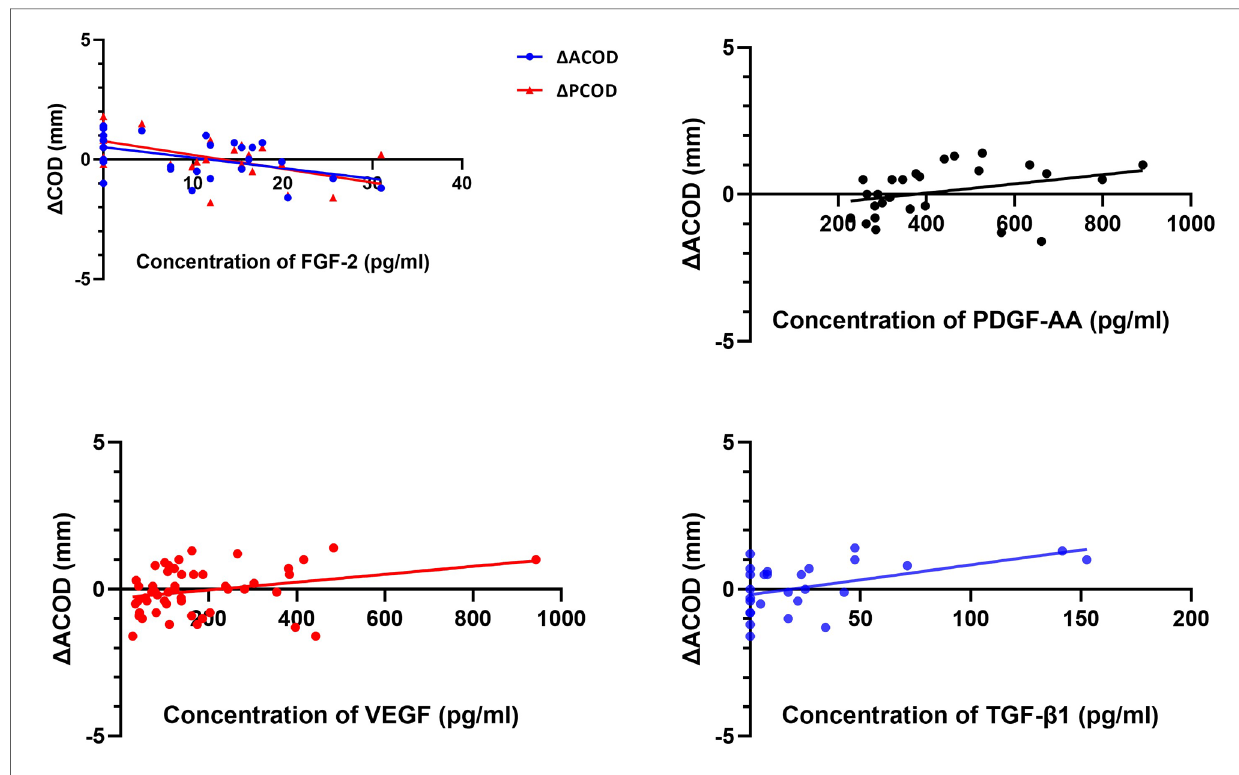
FIGURE 5 Correlation between Δ COD and the concentrations of FGF-2, PDGF-AA, VEGF and TGF- β